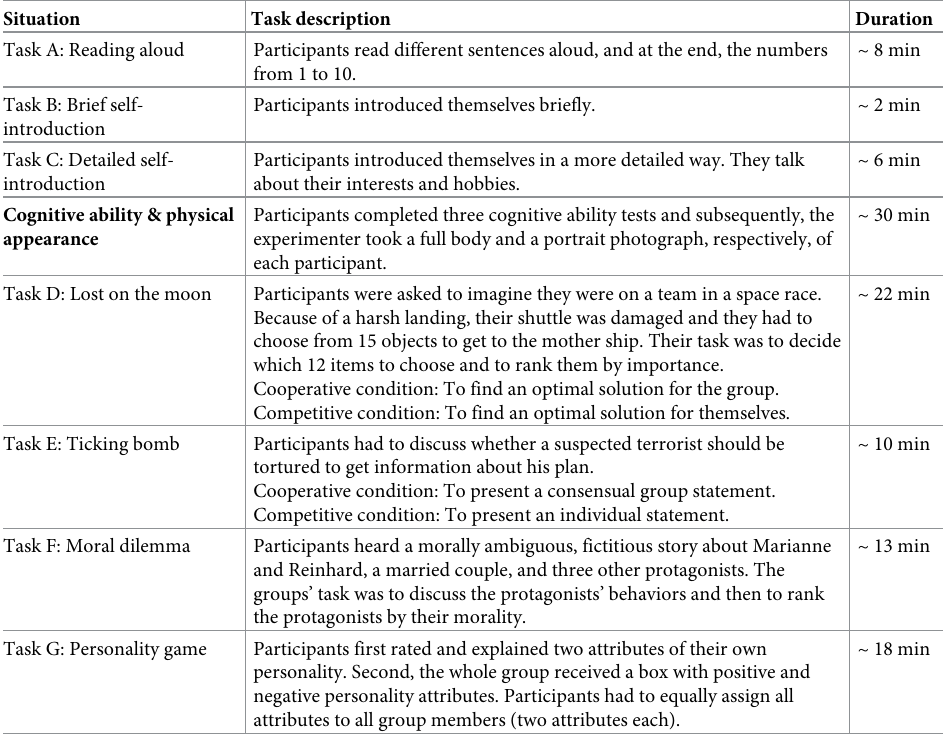
Table 4. Task overview for